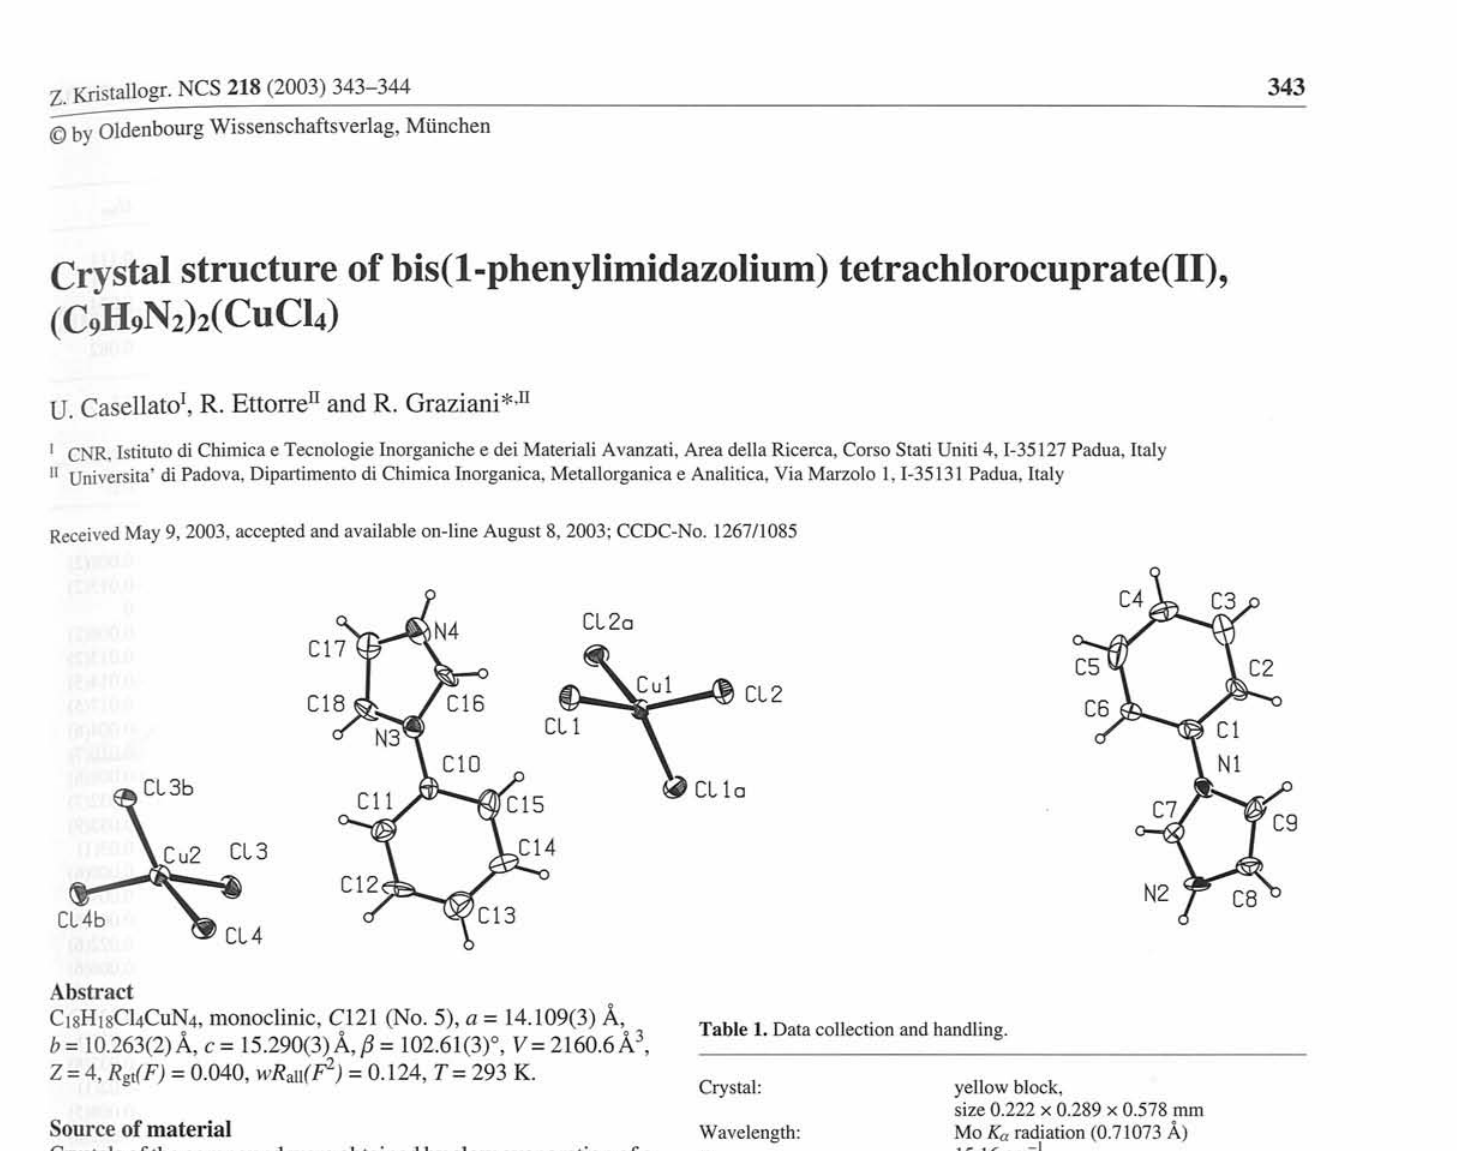
Table 1. Data collection and handling.